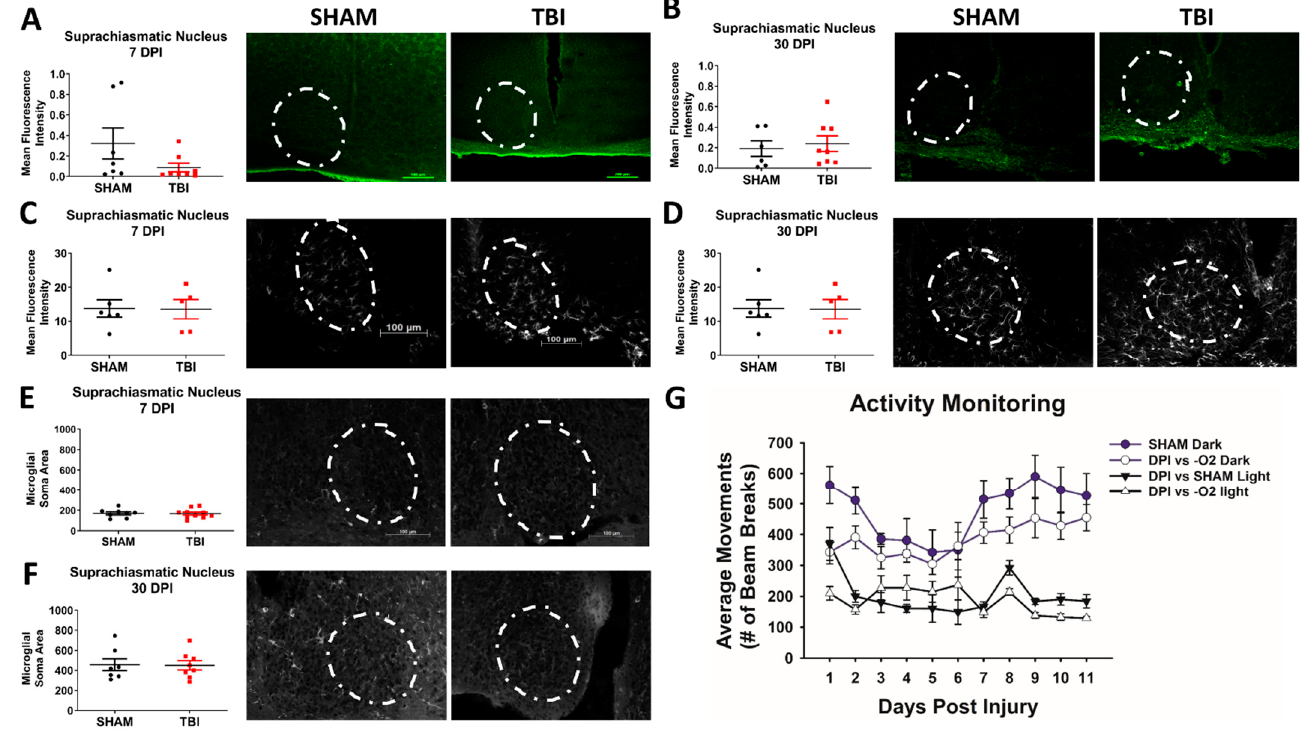
Figure 4. There are no circadian rhythm deficits or histological changes in the suprachiasmatic nucleus of iTON mice. Show is Fluoro-jade B ( A , B ), GFAP expression ( C , D ), and microglial soma area ( E , F ) in the Suprachiasmatic Nucleus (SCN). ( G ) Shows activity monitoring results. Representative photomicrographs taken at 10× magnification. White dashed lines indicate region of interest/area where measurements were taken. Scale bars indicate 100 μ m and are the same across all images.